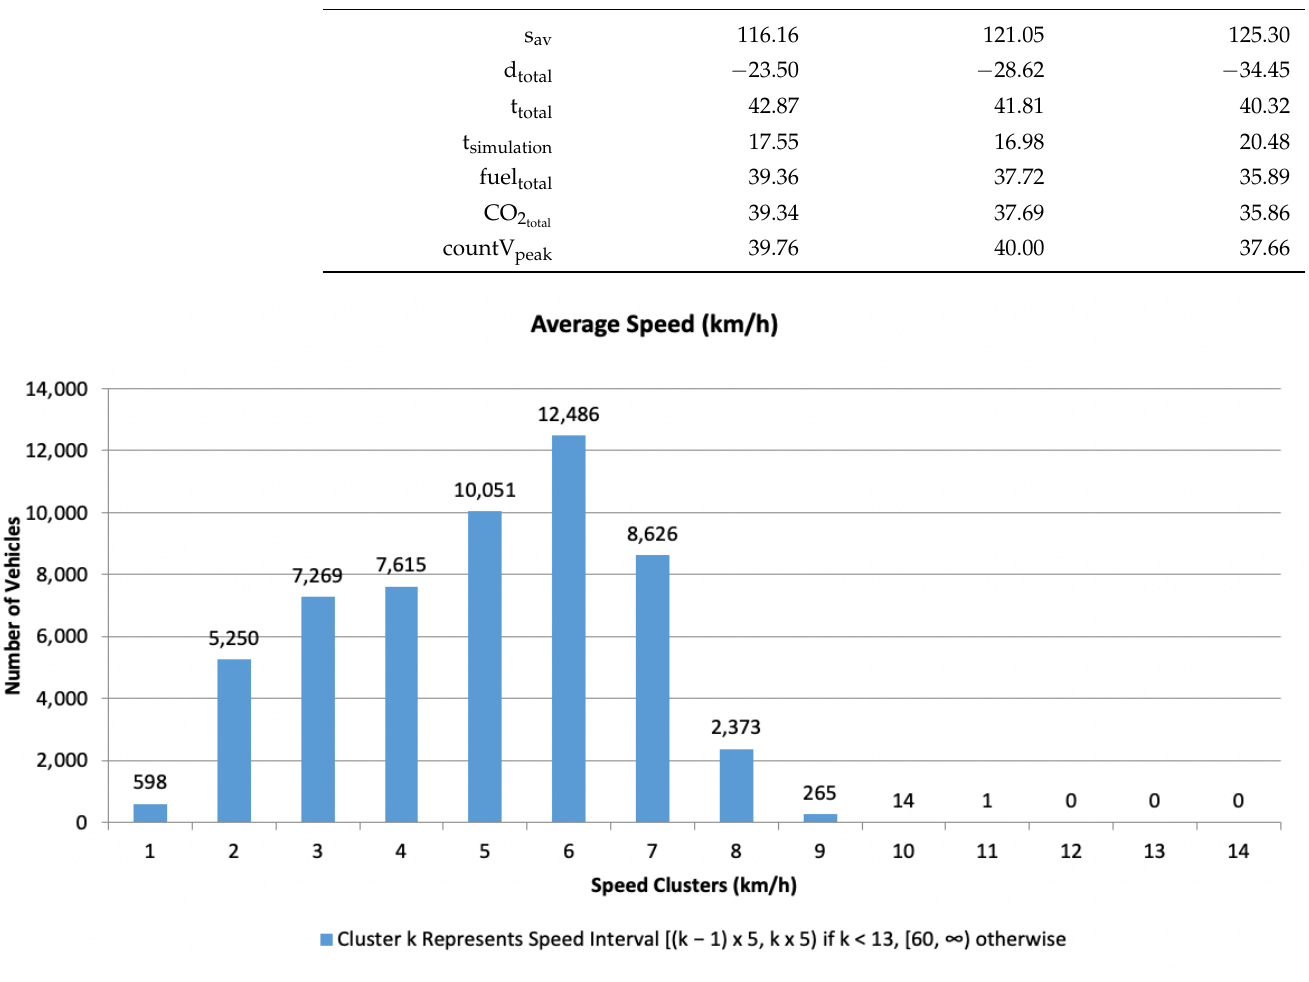
Figure 7. Speed distribution in clusters for 50 K+ simulated vehicles in Bucharest with δ = 4.